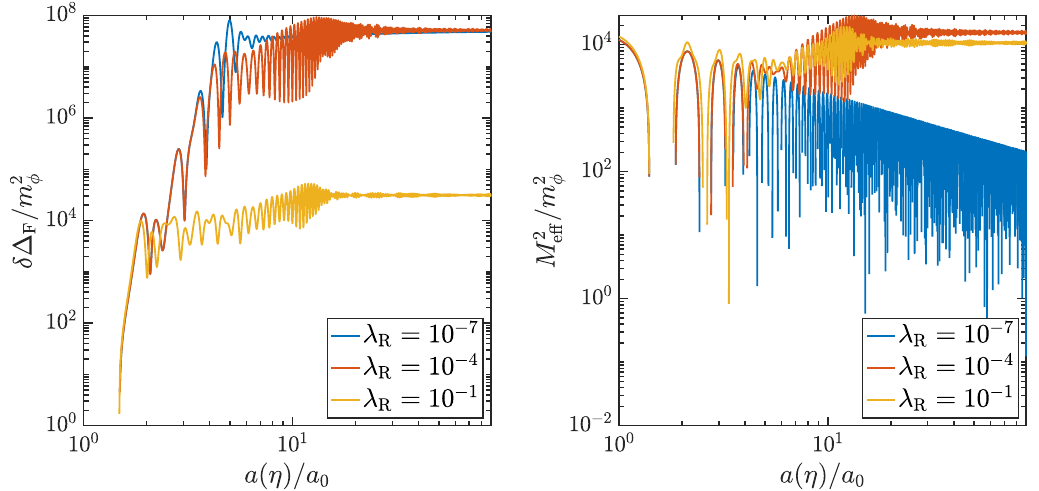
Figure 1 . The two-point function δ ∆ F (left panel) and the effective mass function M 2 panel). The results are shown for λ R ∈ { 10 − 7 , 10 − 4 , 10 − 1 } , ¯ ξ R = 50 and Γ = 0 .